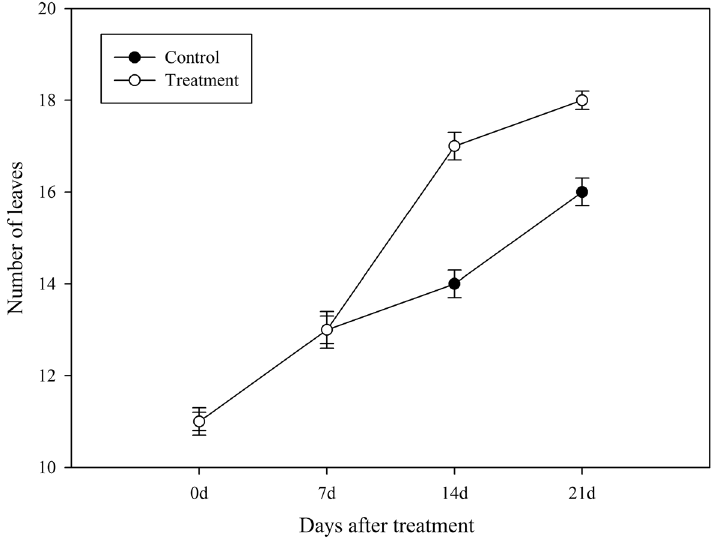
Figure 3. Effects of Chlorella extracts on number of leaves plant -1 . The number of leaves plant -1 (Control group and Treatment group) were counted from the 0 to 21th day after Chlorella extracts treatment. Control: no Chlorella extracts treatment; Treatment: plants were treated by Chlorella extracts; SAS analysis at 5% is shown in lowercase letters to indicate significant differences. Vertical bars in the figures represent ± SD of five independent biological replicates.